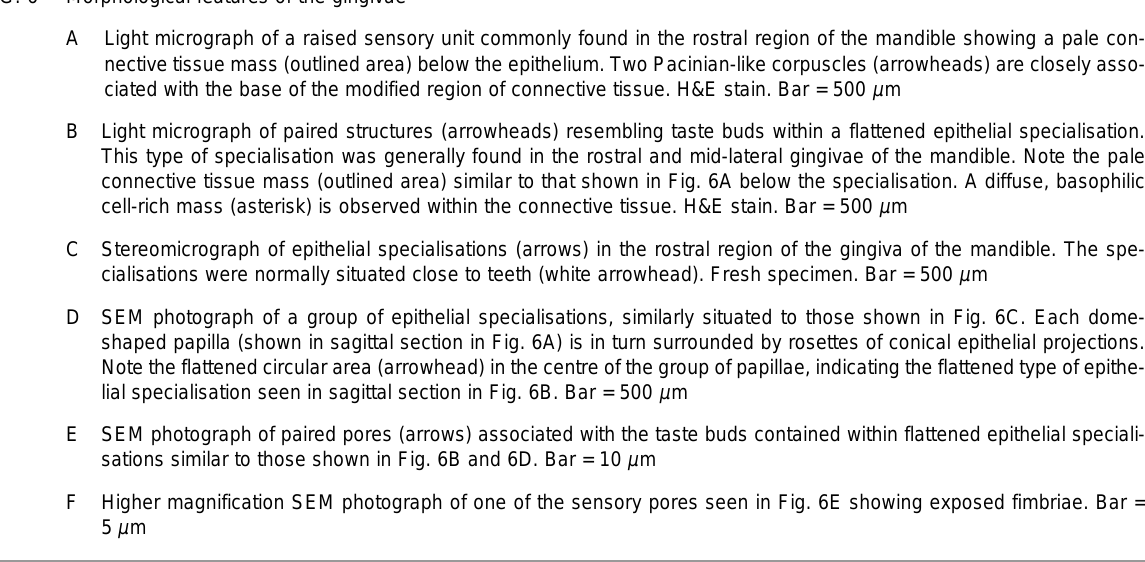
Morphological features of the